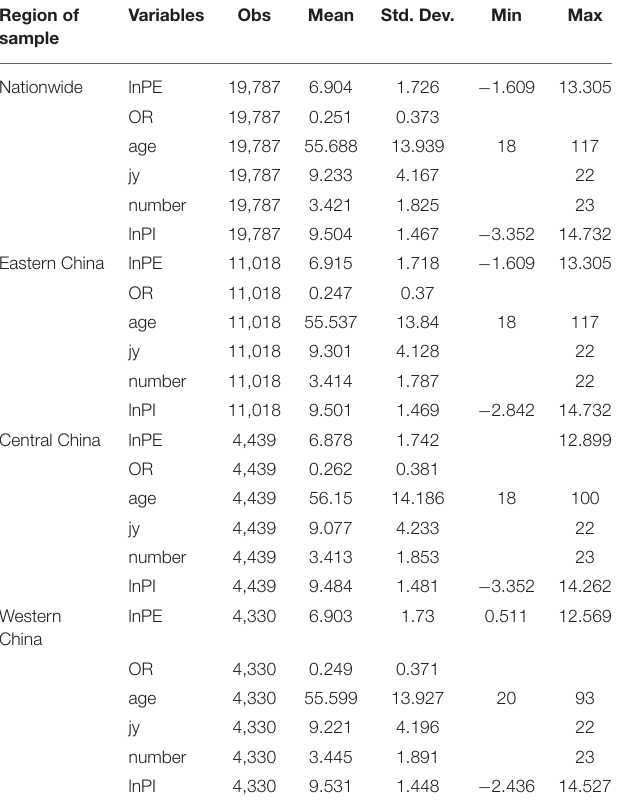
TABLE 2 | Summary statistics of variables. Region of sample